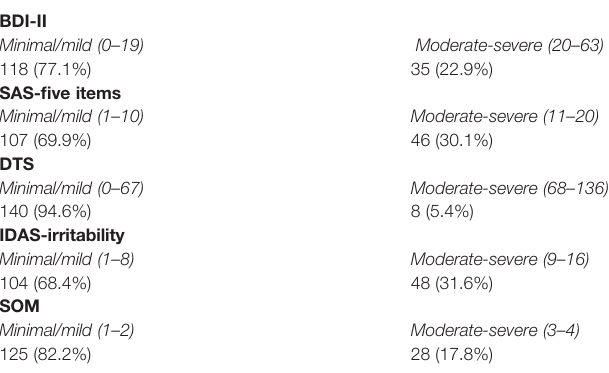
TABLE 4 | Results of the psychometric scales and ranges (cases and